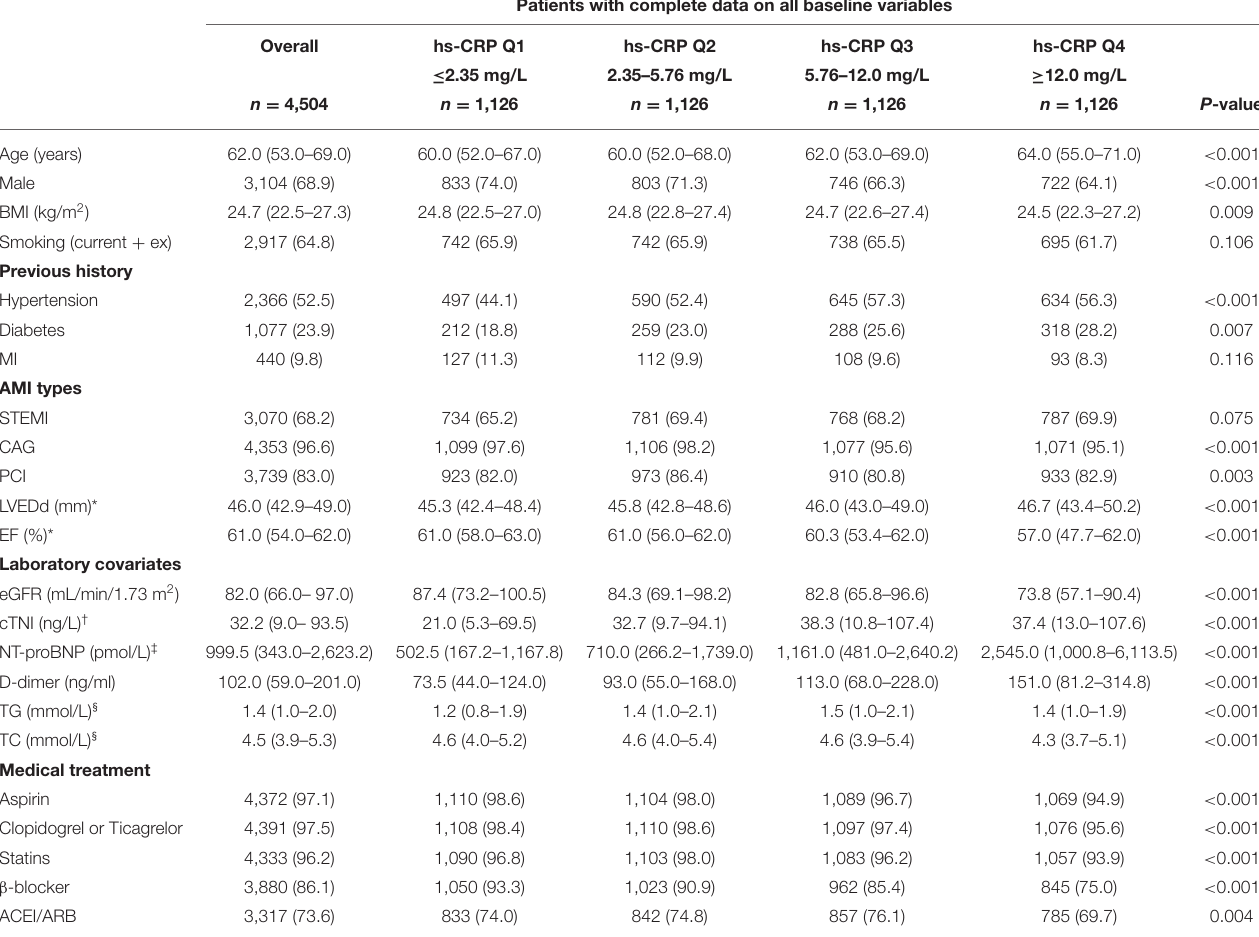
Patients with complete data on all baseline